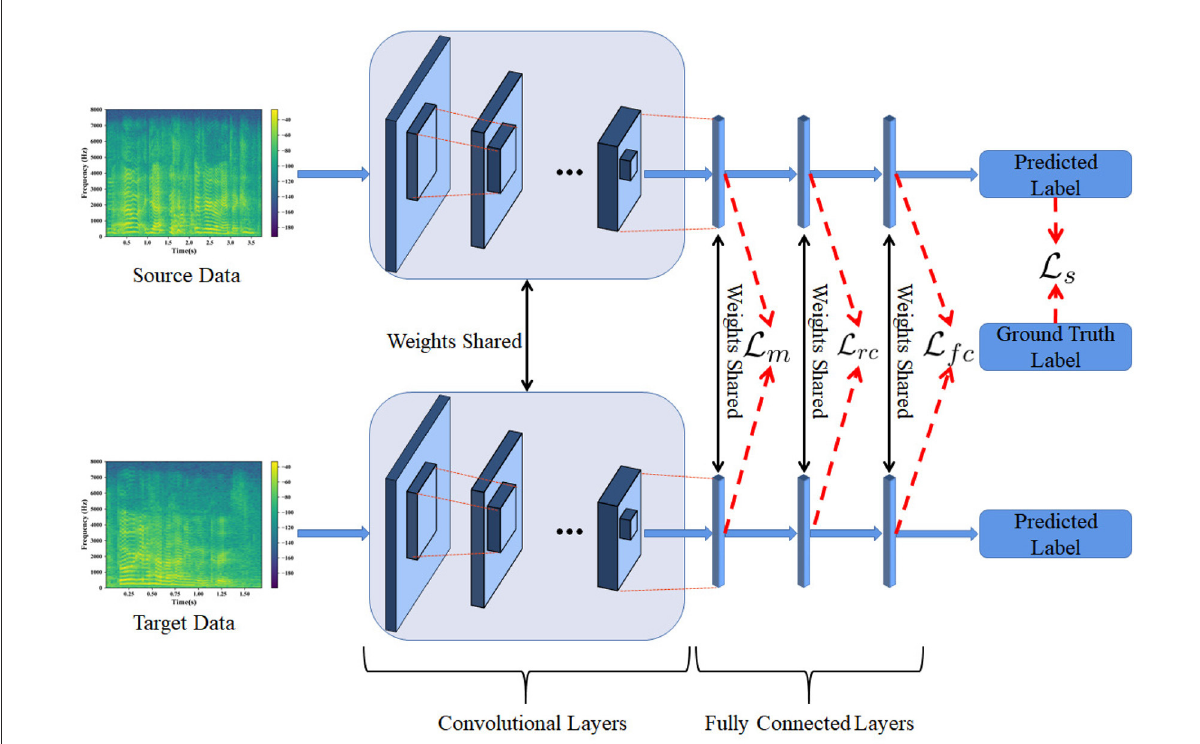
FIGURE1 The overview of progressive distribution adapted neural networks (PDAN). The PDAN uses the speech spectrums as the inputs and directly builds the relationship between the emotion labels and speech signals. It consists of several convolutional layers and three fully connected (FC) layers and is trained under the guidance of the combination of four loss functions, i.e., emotion discriminative loss L s , marginal distribution adapted loss L m , rough emotion class aware conditional distribution adapted loss L rc , and fine emotion class aware conditional distribution adapted loss L fc